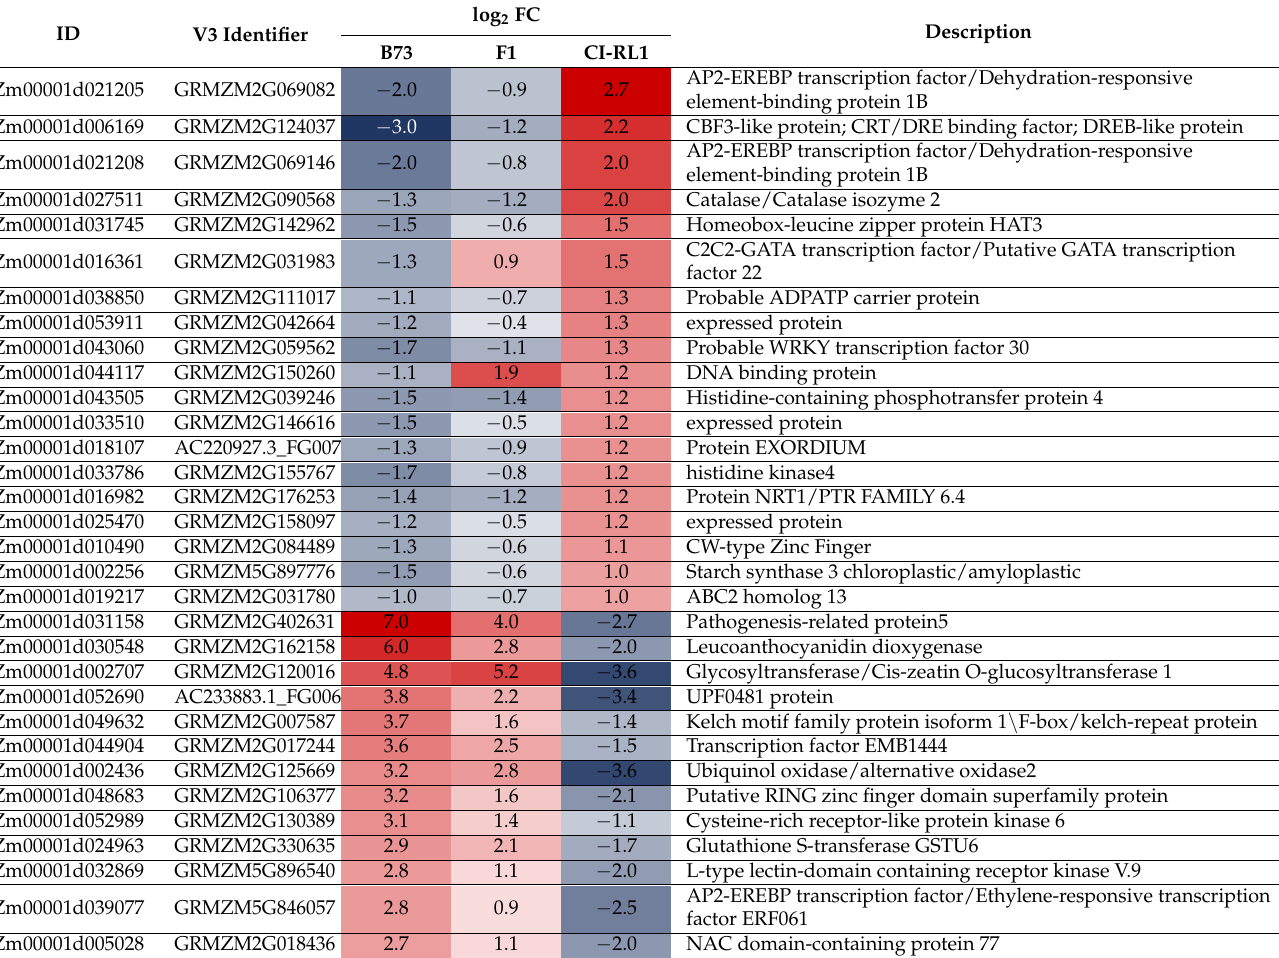
Table 3. Candidate genes selected after differentially expressed genes (DEGs) analysis. Down- (in blue) and upregulated (in red) genes, maize transcript IDs, fold-change expression levels (log 2 ), and the information for V3 identifiers and descriptions are